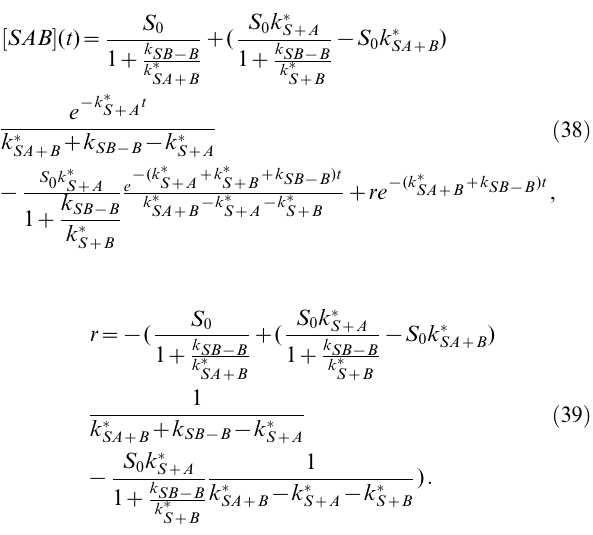
~ k (cid:3) ~ 0 : 3 and k (cid:3) ~ 0 : 1 , 0 : 5 , 5 from bottom to S z A SB z A S z B 1 & 0 : 05 . After A has risen to a high level, recruitment of B becomes & SA z B 47 { 20 ~ 0 . The curves always resemble a monoexponential function. SA z B